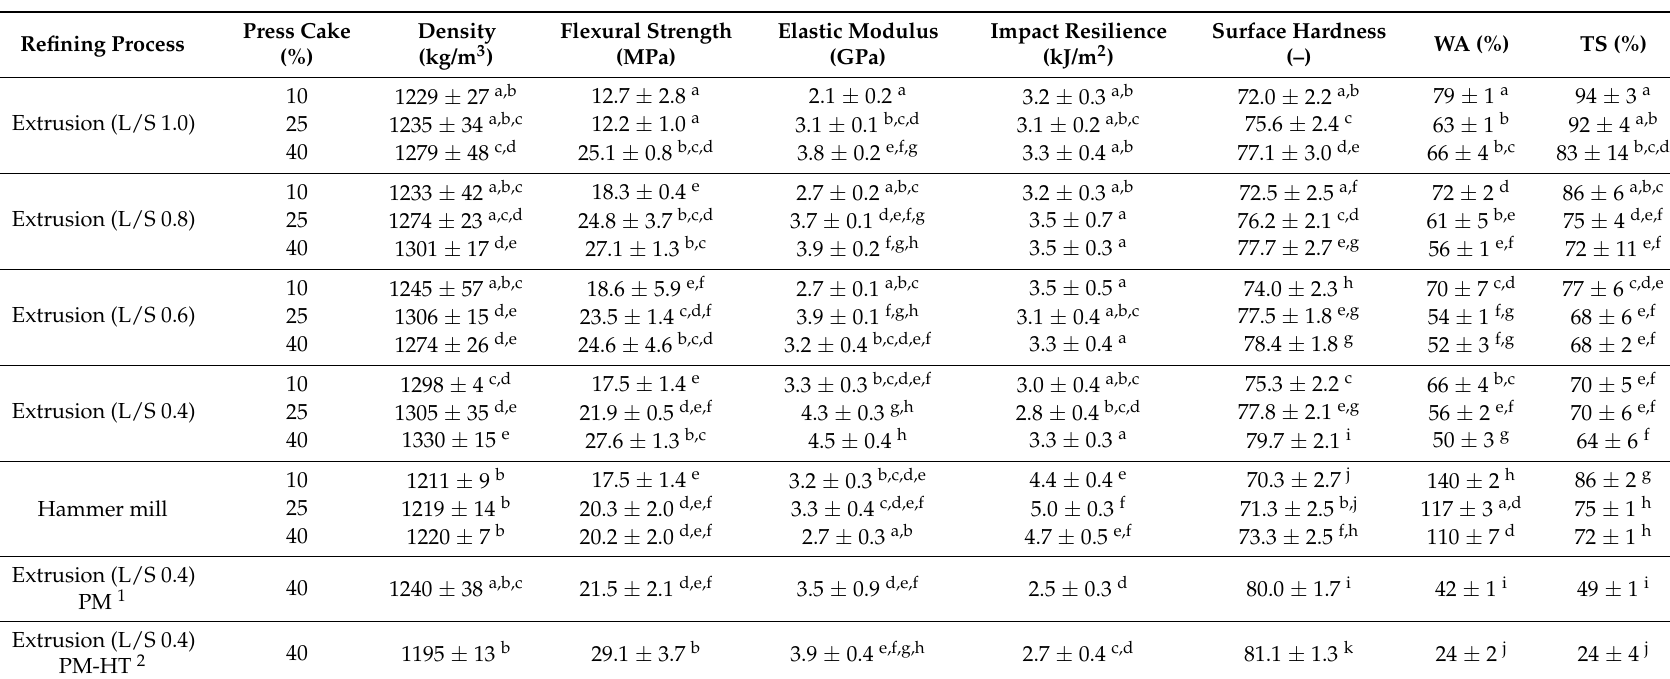
Table 4. Fiberboard characteristics produced from refined coriander straw and deoiled coriander press cake. WA, water absorption; TS, thickness swelling; PM, premixed raw material; PM-HT, premixed raw material and heat treated